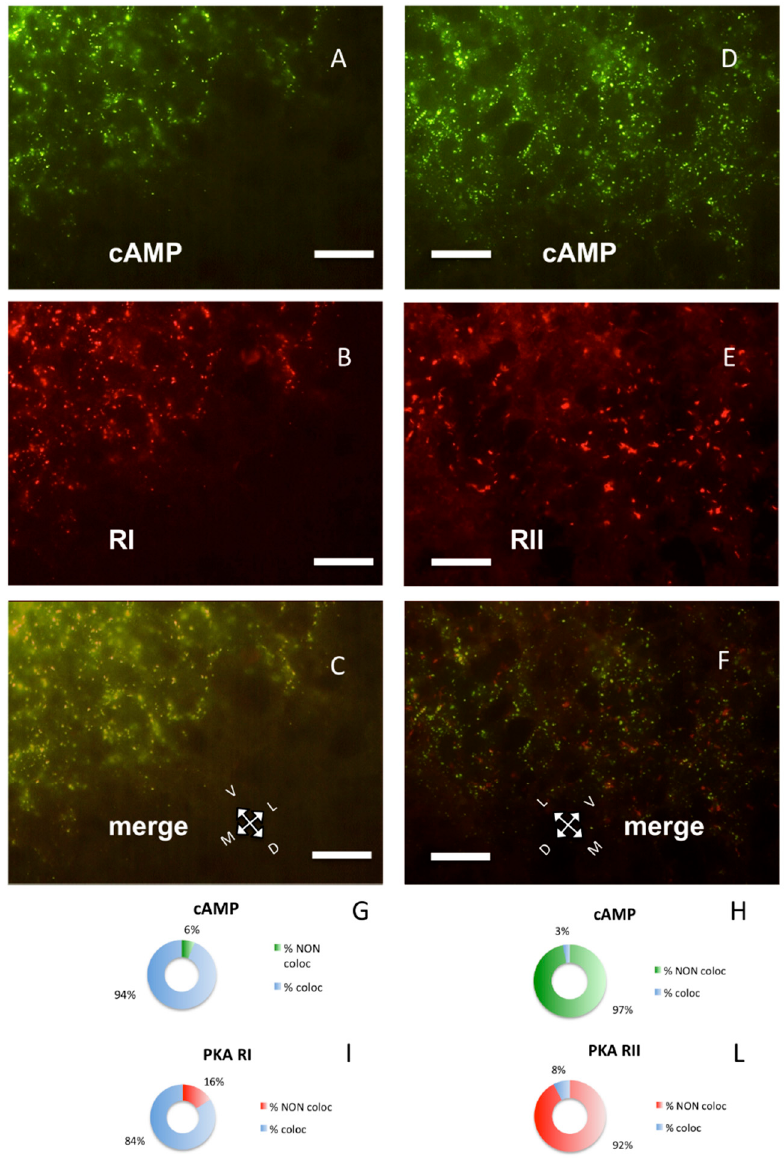
Figure 2. Parietal cortex coronal sections, scale bar: 10 µm. ( A ) Alexa488-cAMP (green) labeling of the cerebral S1BF cortex, pia on the lower right. ( B ) In the same field, RI immunolabeling (red). ( C ) Merge of A and B , showing coincidence of fluorescent cAMP and RI (yellow). ( D ) Alexa488-cAMP labeling (green) of the cerebral S1BF cortex, pia on the lower side. ( E ) Same field, RII immunolabeling (red). ( F ) Merge of D and E shows no colocalization of red and green signals. G – I : Quantification of superimposition in C ( n = 1045). ( G ) Percentage of colocalization of cAMP (% coloc, light blue, n = 454) or not (% NON coloc, green n = 30) with PKA RI in C . H – L : Quantification of superimposition in F ( n = 1426). ( H ) Percentage of colocalization of cAMP (% coloc, light blue, n = 31) or not (% NON coloc, green, n = 987) with PKA RII in F . ( I ) Percentage of colocalization of PKA RI immunolabeling (% coloc, light blue, n = 471) or not (% NON coloc, red, n = 90) with cAMP signal in C . ( L ) Percentage of colocalization of PKA RII immunolabeling (% coloc, light blue, n = 31) or not (% NON coloc, red, n = 377) with cAMP signal in F